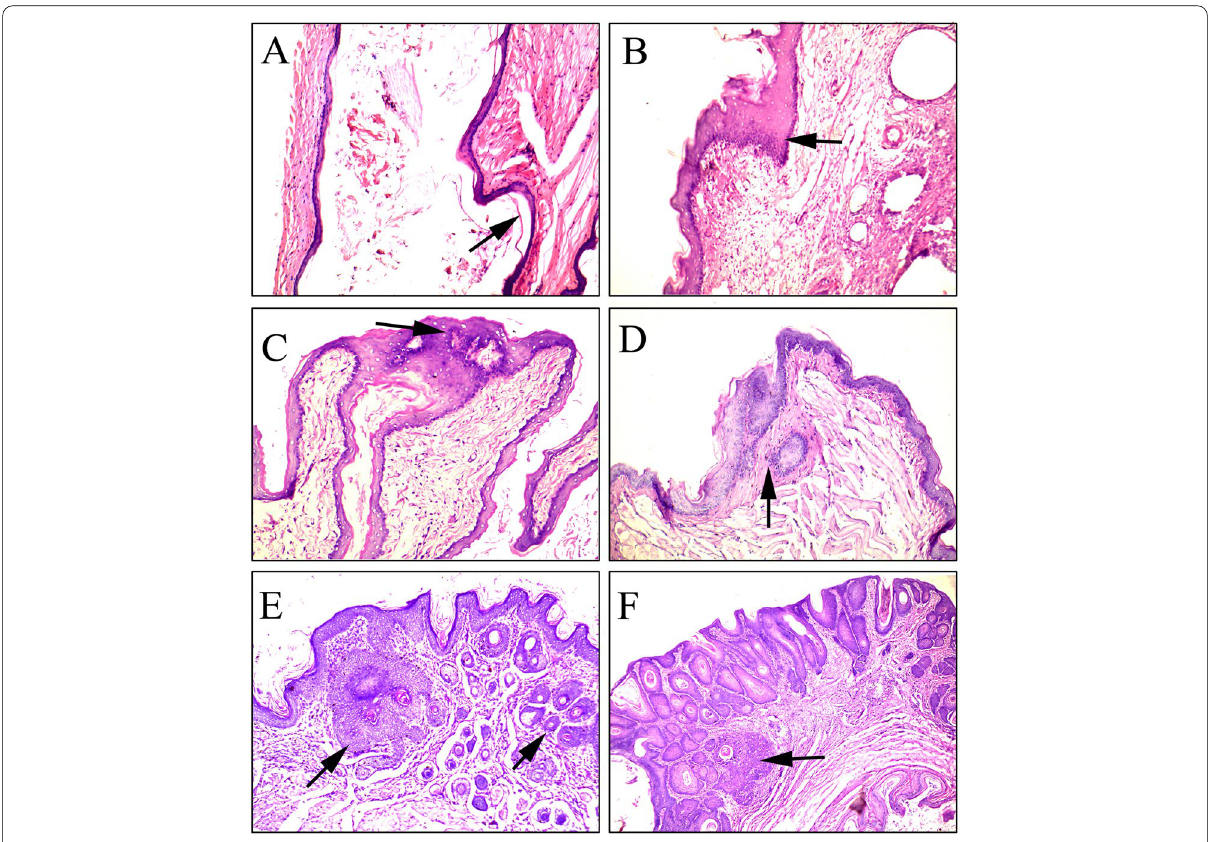
Fig. 2 A photomicrograph showing induced carcinogenesis during treatment with DMBA. A Normal epithelium lining of hamster buccal pouch, group 1. B Focal thickening without any cellular atypia, group 2A. C Mild dysplasia, group 2A. D Microinvasion of the malignant epithelial cells into underlying tissue, group 2A. E Invasive well-differentiated OSCC, group 2A. F Invasive well- to moderate-differentiated OSCC, group 2A. All pictures were stained by H&E and taken at 100 except 2A and 2F at 40 ×